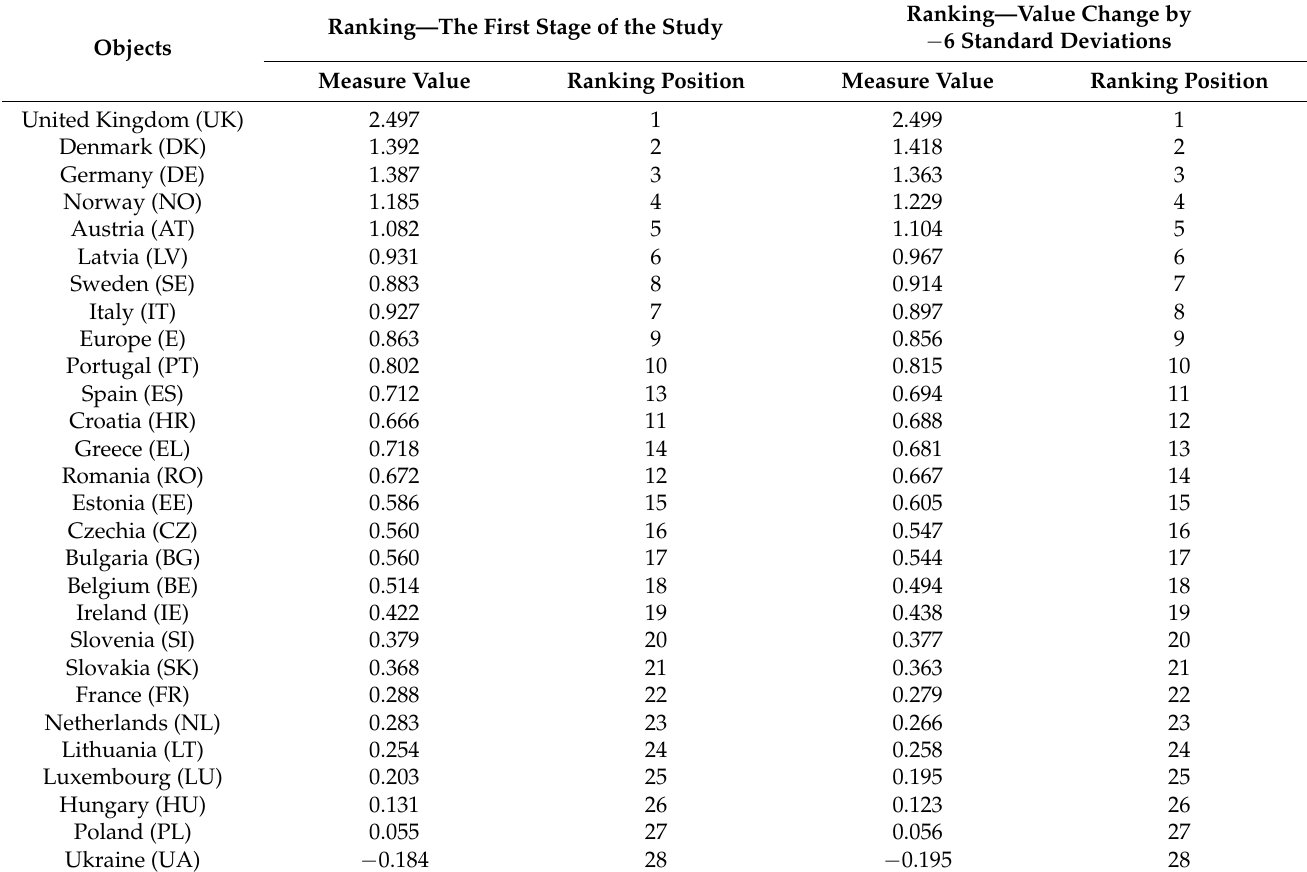
Table 3. Ranking of objects for VMCM after changing value by − 6 of standard